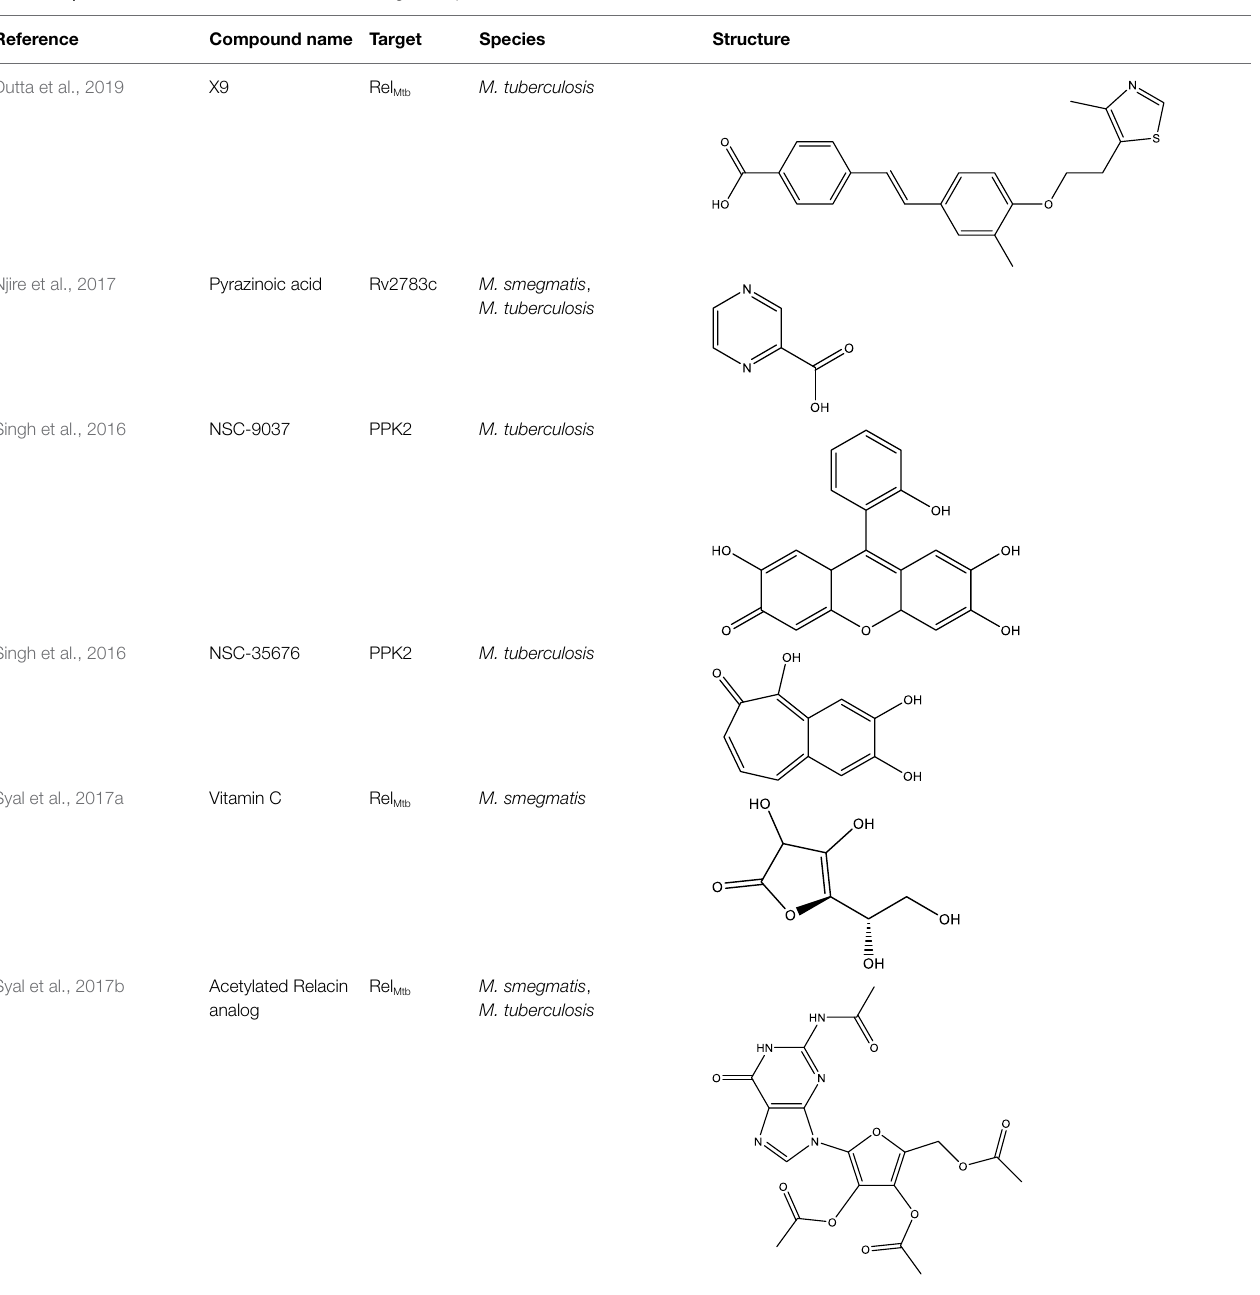
TABLE 1 | Small molecule inhibitors of bacterial stringent response